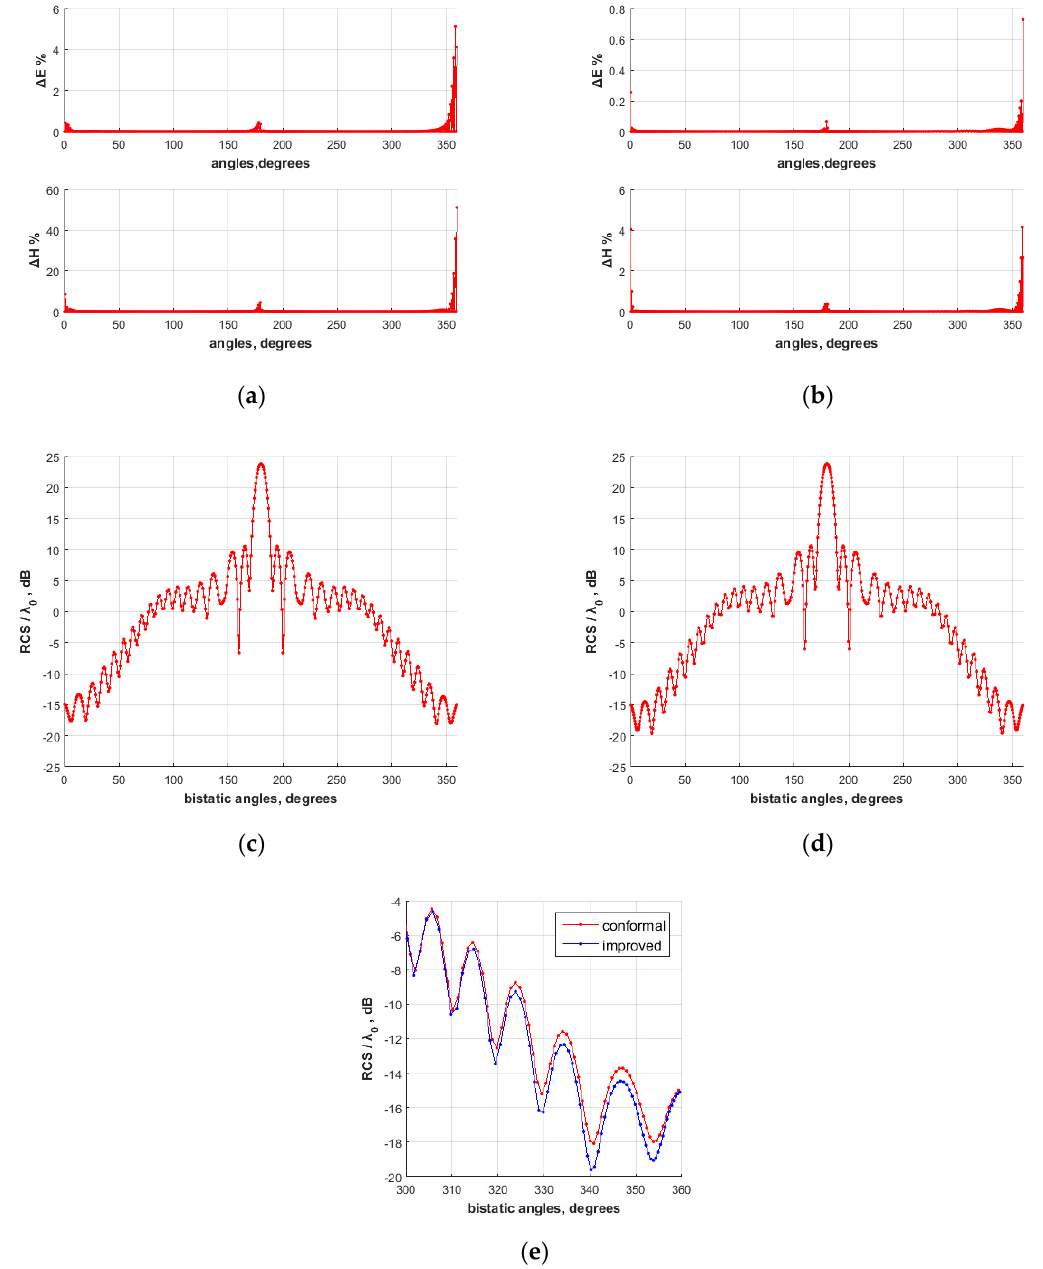
Figure 8. Results for lossy dielectric scatterer: ( a ) error in the generic boundary condition (BC) of the E and H field via conformal auxiliary surface placement; ( b ) error in the generic BC of the E and H field via improved auxiliary surface placement; ( c ) computed RCS for conformal auxiliary surfaces; ( d ) computed RCS for improved auxiliary surfaces; ( e ) RCS compared for both auxiliary surface placements (conformal shown in red, improved shown in blue), focused in angles near the backscattering